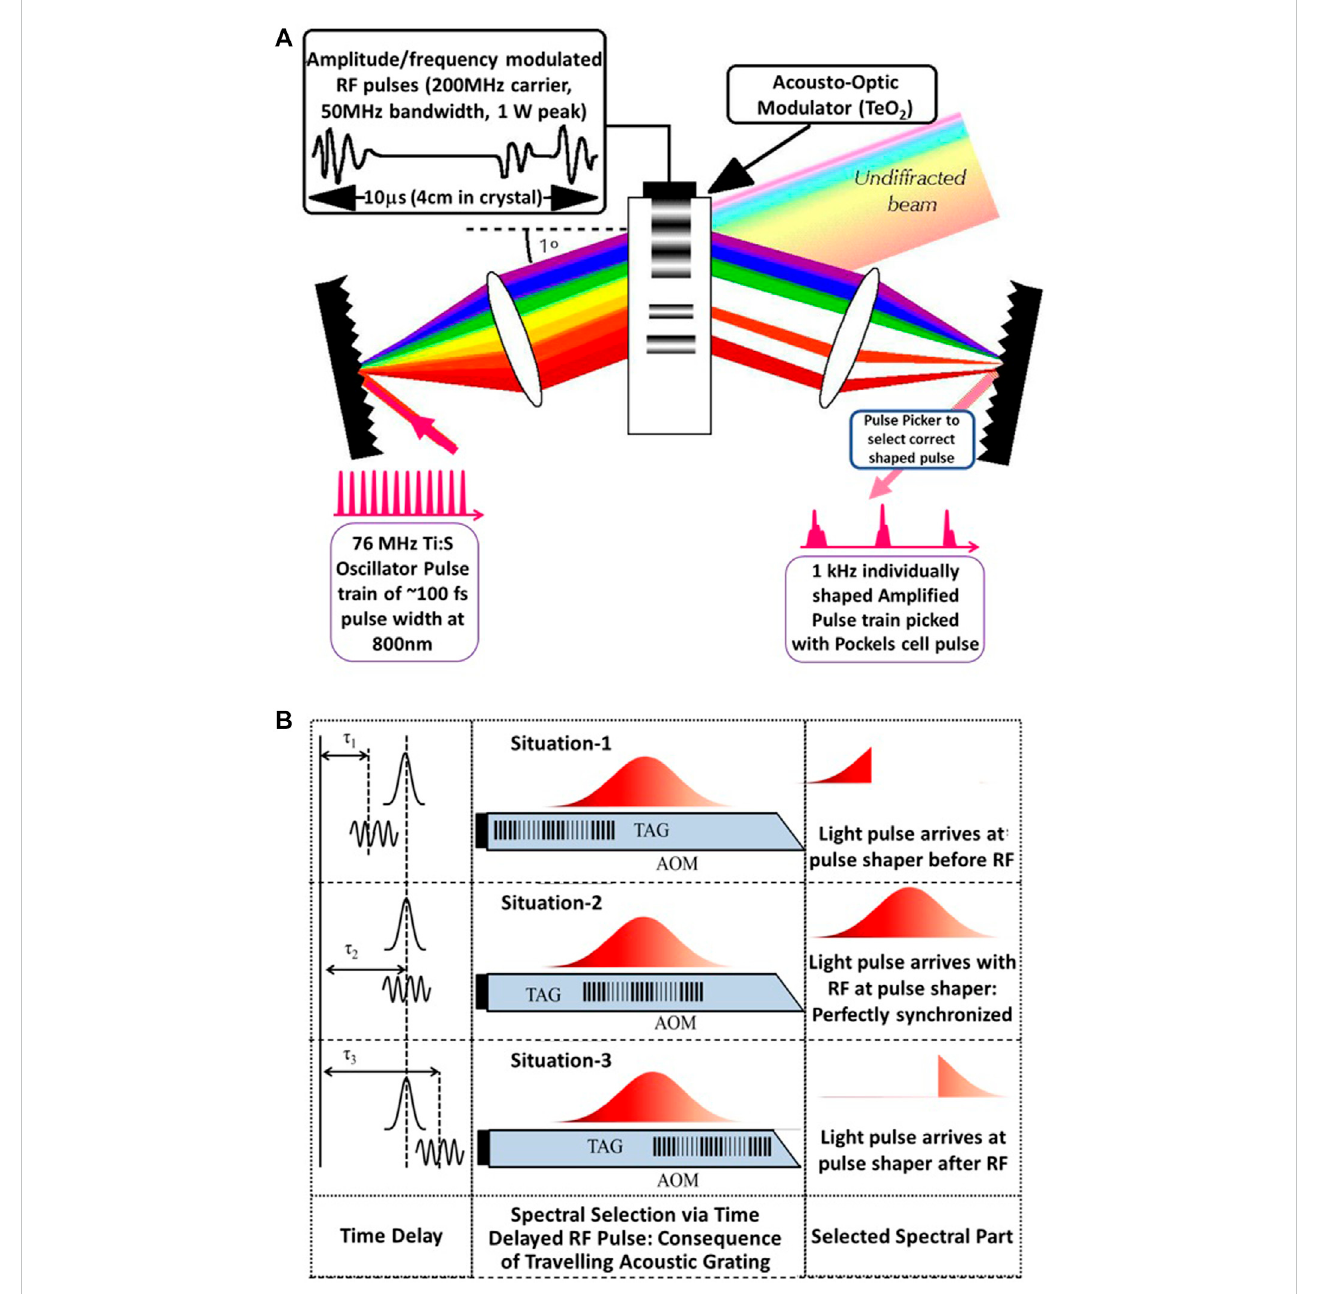
FIGURE 2 (A) Schematic of the Fourier Domain Pulse Shaping approach. For ultrashort pulses, the two lenses can be replaced with curved mirrors. (B) Low repetition rate femtosecond pulse shaping in the Fourier domain involves the selection of the desired shaped pulse, which is achieved by the Pockels